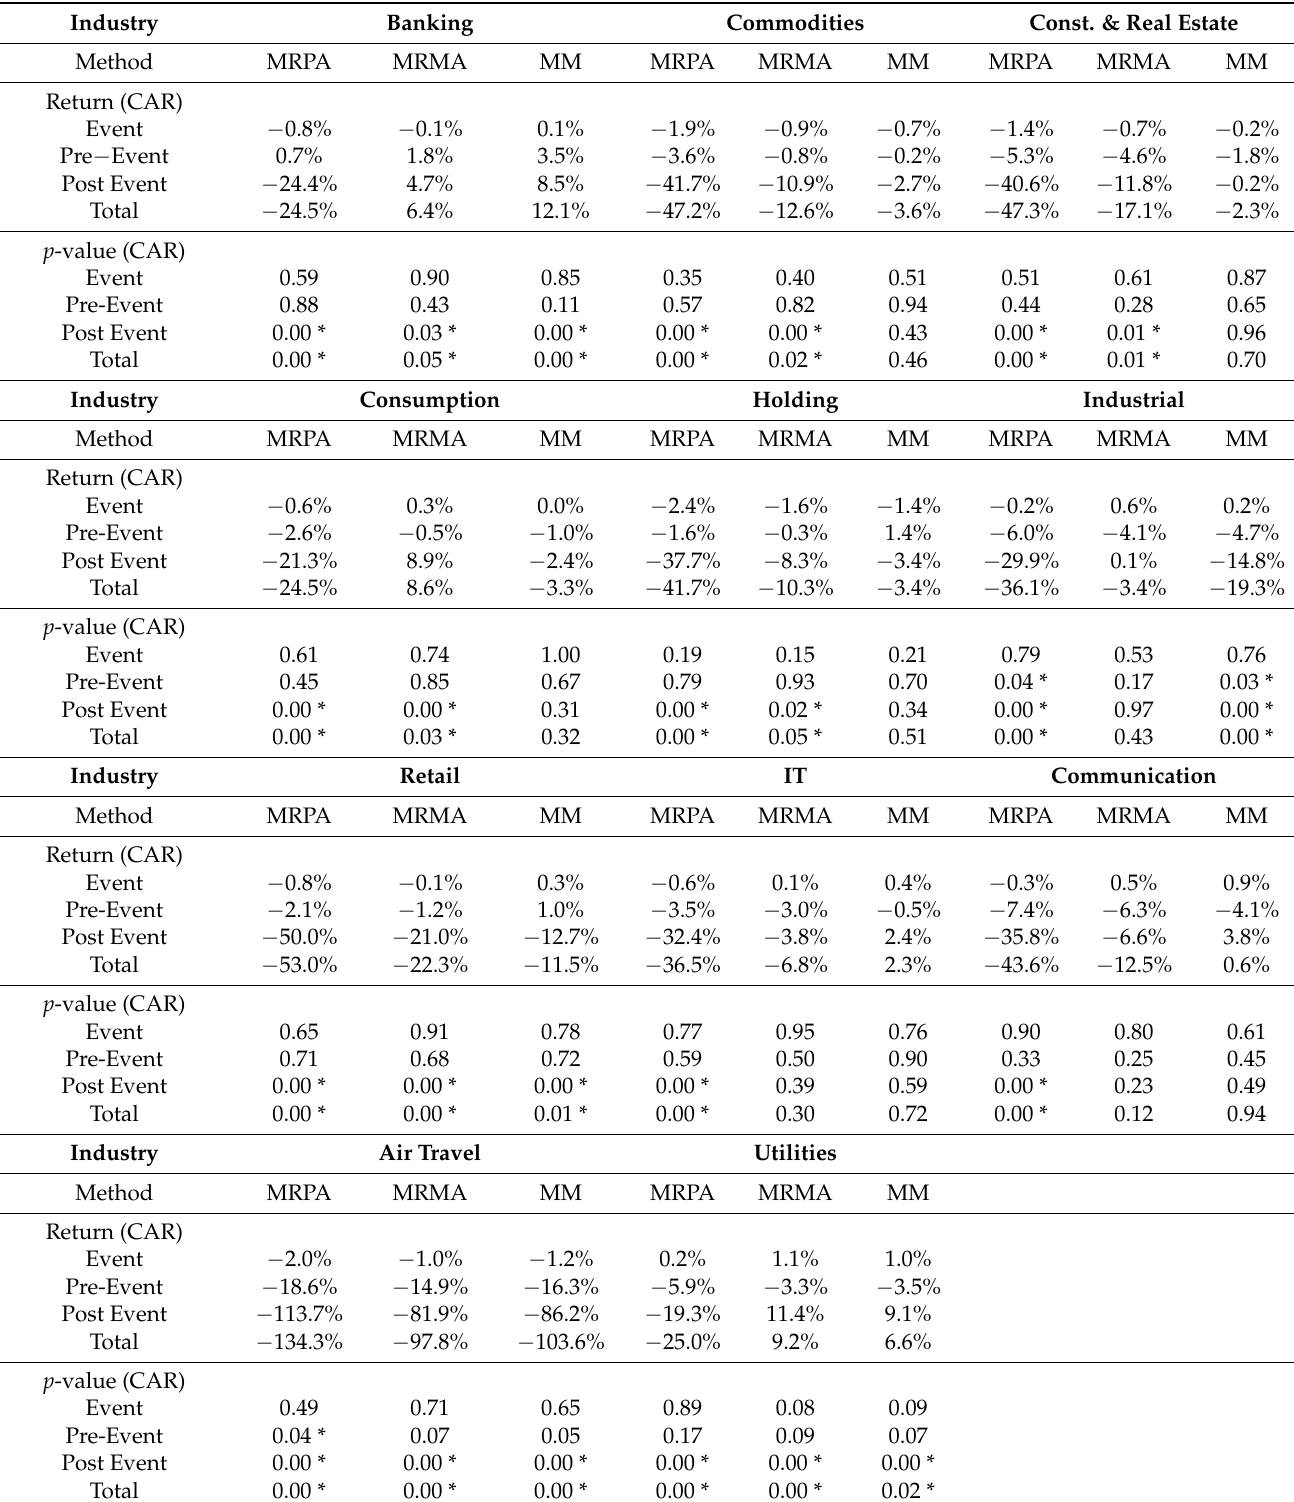
Table 9. CAR results showing the average of the returns before, during, and after the event and their statistical significance. Industry Banking Commodities Const. & Real Estate Method